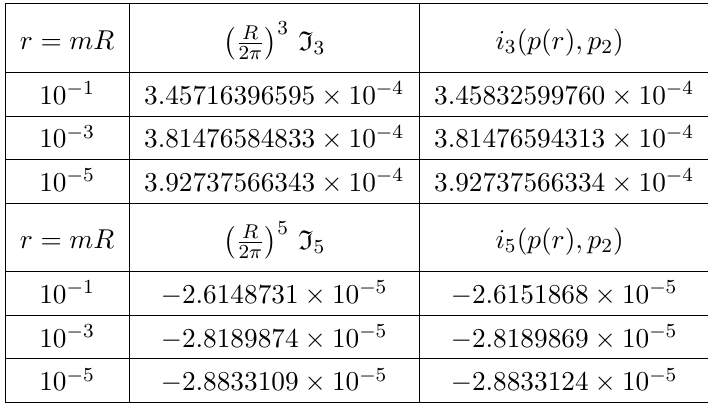
Table 2 . The vacuum eigenvalues of the (cid:12)rst two higher spin local IM in the sausage model for n = 1 and p 2 = 3 k = 5 . The numerical values were calculated from the solution of the NLIE and 2 13 formula (5.48). The last column gives the vacuum eigenvalues of the chiral local IM, i 3 ( p ( r ) ; p 2 ) and i 5 ( p ( r ) ; p 2 ), where p ( r ) is the solution to the quantization condition (5.25). The limiting values at r = 0 are given by i 3 (0 ; p 2 ) = 39031 = 4 : 067 : : : (cid:2) 10 (cid:0) 4 ; i 5 (0 ; p 2 ) = (cid:0) 137442779 = 95964960 4638370376640 (cid:0) 2 : 963 : : : (cid:2) 10 (cid:0) 5 . Explicit expressions for i 3 and i 5 can be found in ref.